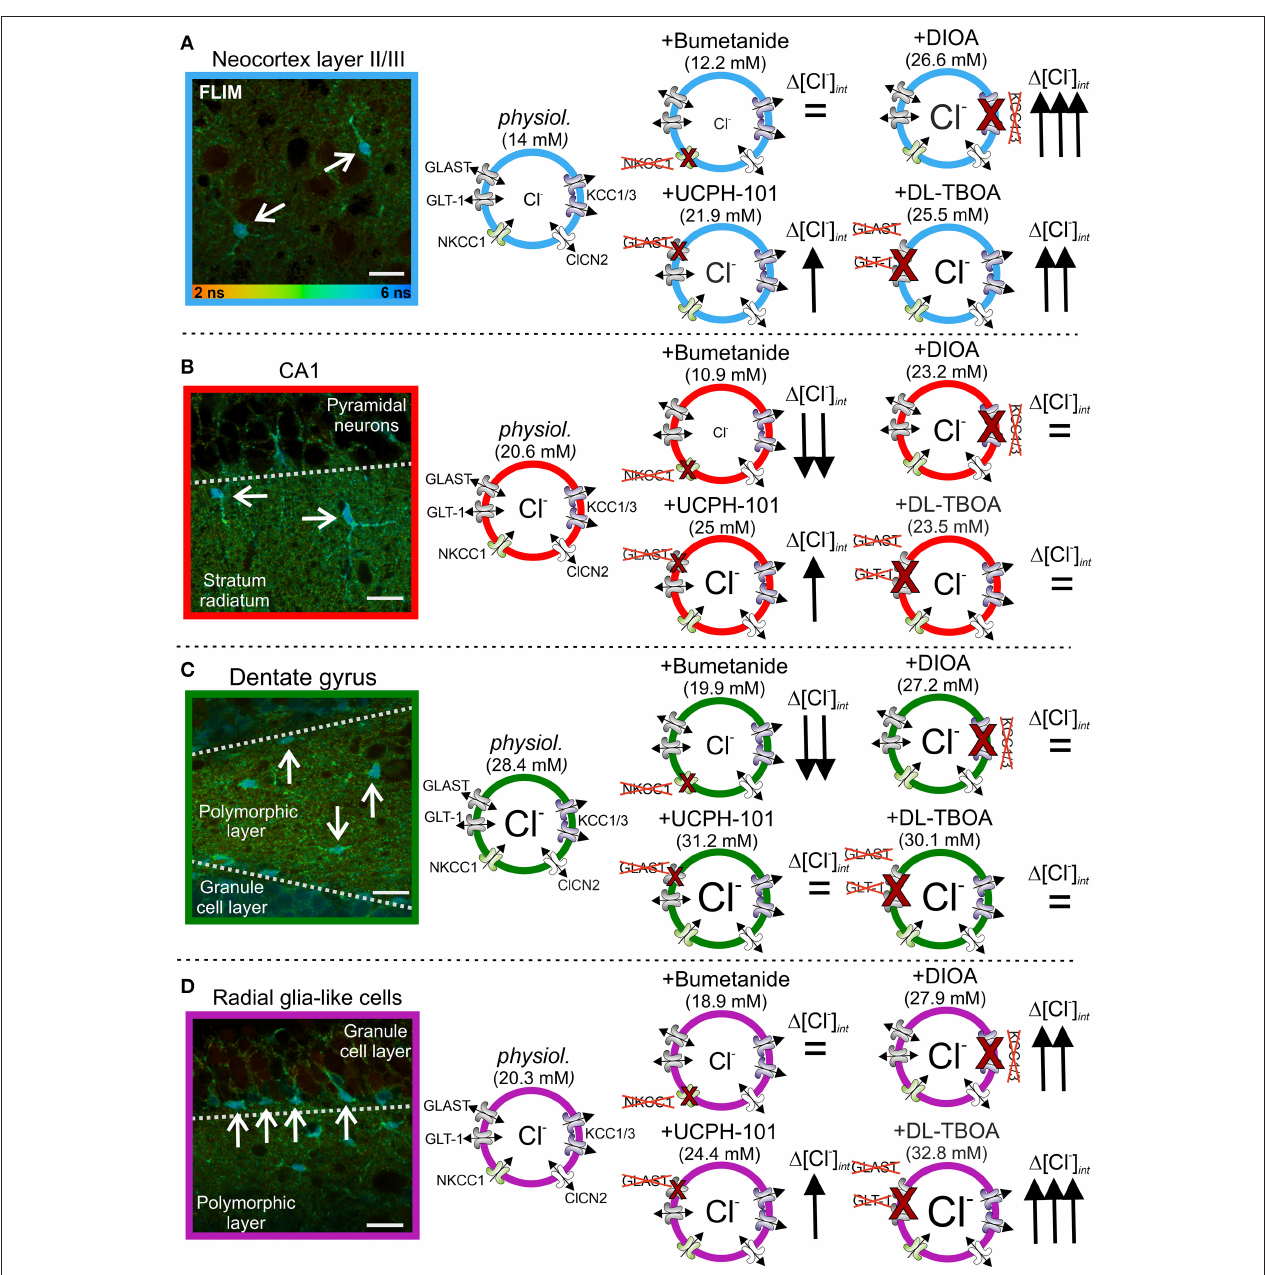
FIGURE 3 | Glial [Cl − ] int varies between brain regions. (A–D) Fluorescence lifetime microscopy (FLIM) images of neocortical (A) and hippocampal (B) CA1 and (C) dentate gyrus astrocytes, as well as (D) radial-glia-like cells (arrows). The [Cl − ] int varies between 14mM in cortical astrocytes and 28mM in dentate gyrus astrocytes. Modification of [Cl − ] int by anion transport blockers illustrate that differences in anion transport protein expression cause this variability. Scale bars: 20 µ m. Modified and reprinted from Engels et al. (2021), with permission.